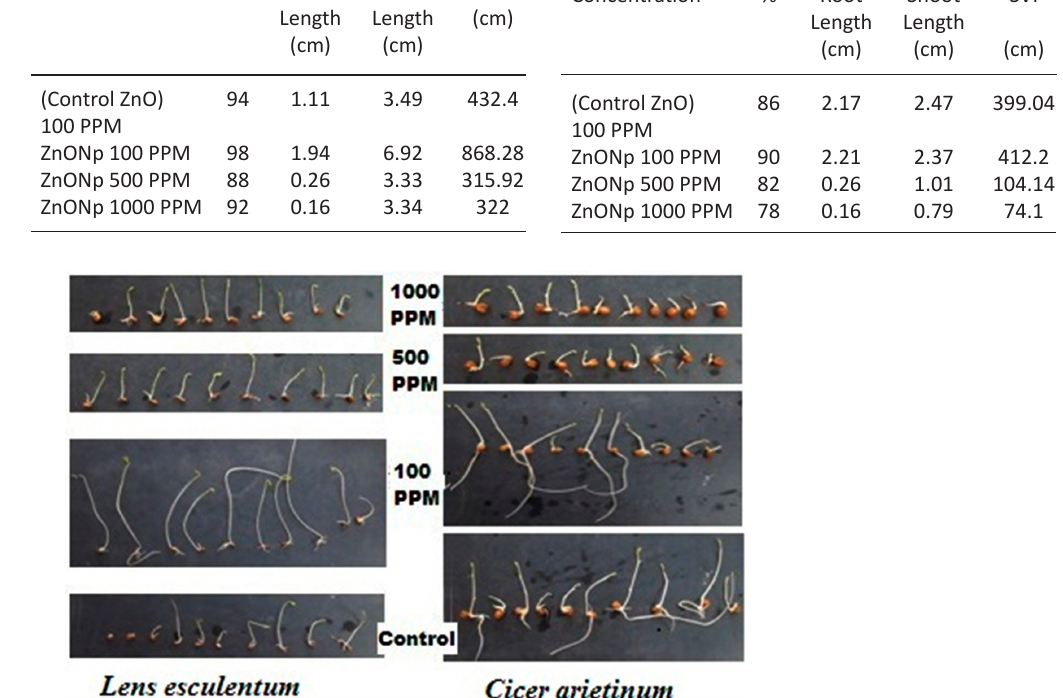
Table 7. Effect of ZnONp on Seedling Vigour Index of Lentil ( Lens esculentum ) Concentration